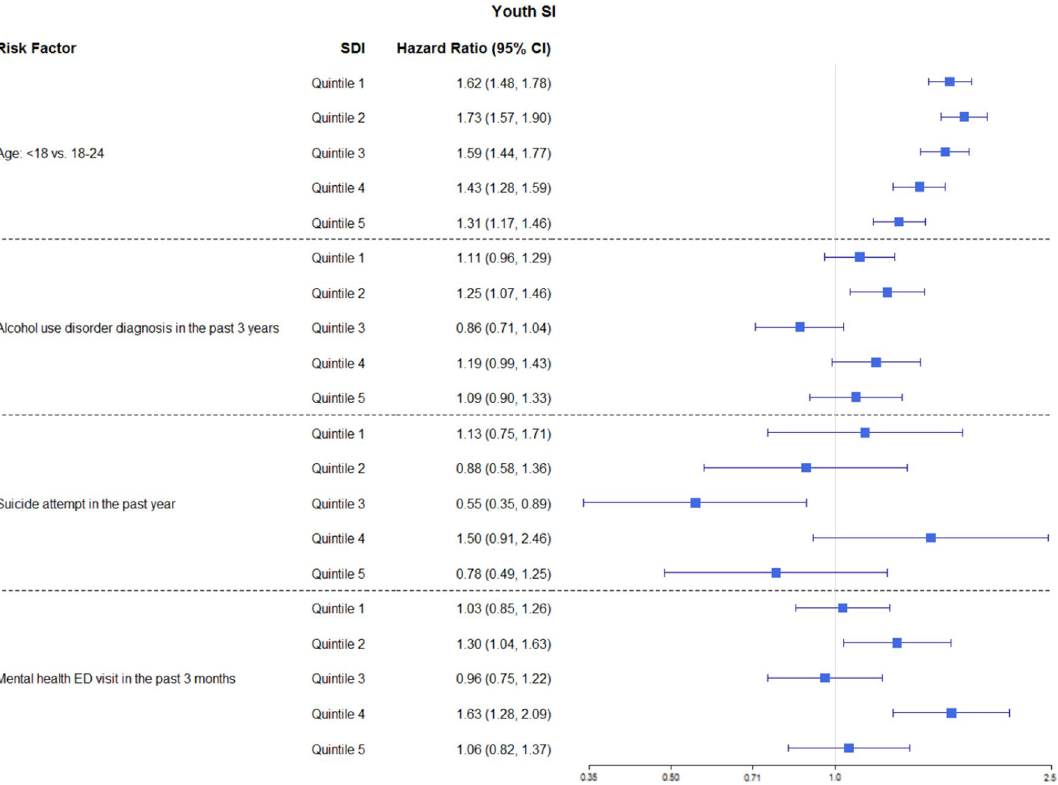
Figure 2. Hazard ratios of risk factors by SDI for youth suicidal ideation (SI) where the interactions were